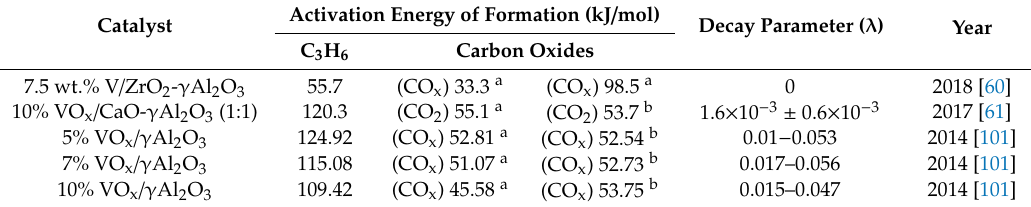
Table 4. Activation Energies and Activity Decay Parameter Values for the Main Products from PODH, as Reported in the